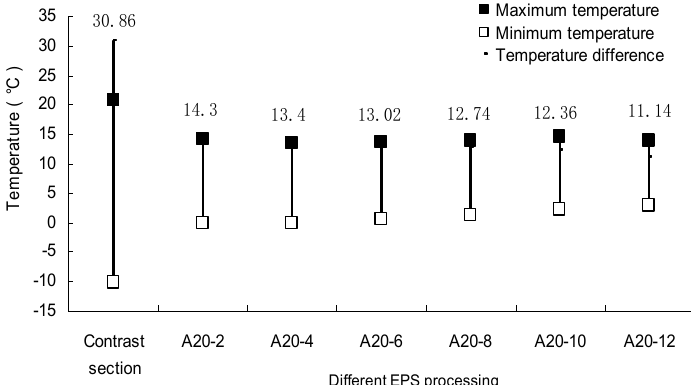
Figure 5. Temperature extremum and temperature difference values of the EPS with different thicknesses. The observational period of this study’s test was 183 days, including 106 days of negative temperatures with no insulation measures in place. The ground temperatures with no